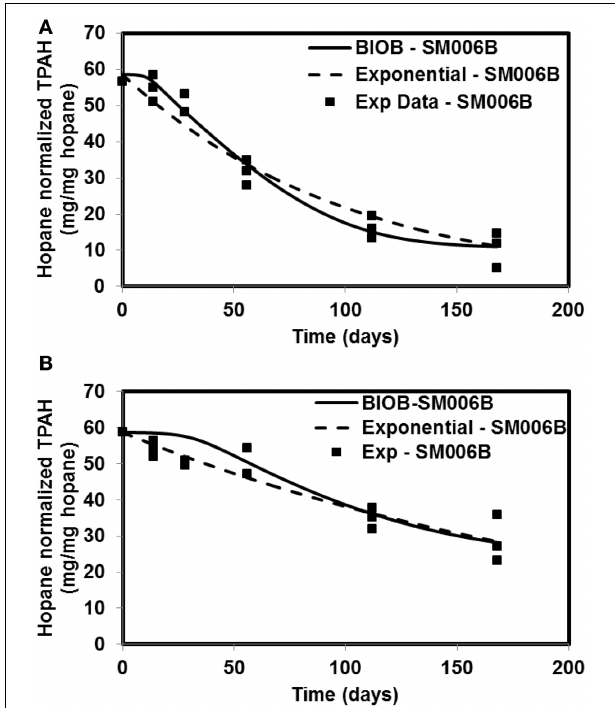
FIGURE 3 | Comparison of model results and the experimental results for Smith Island (SM006B) (A) Nutrient amended experiments (B) Natural